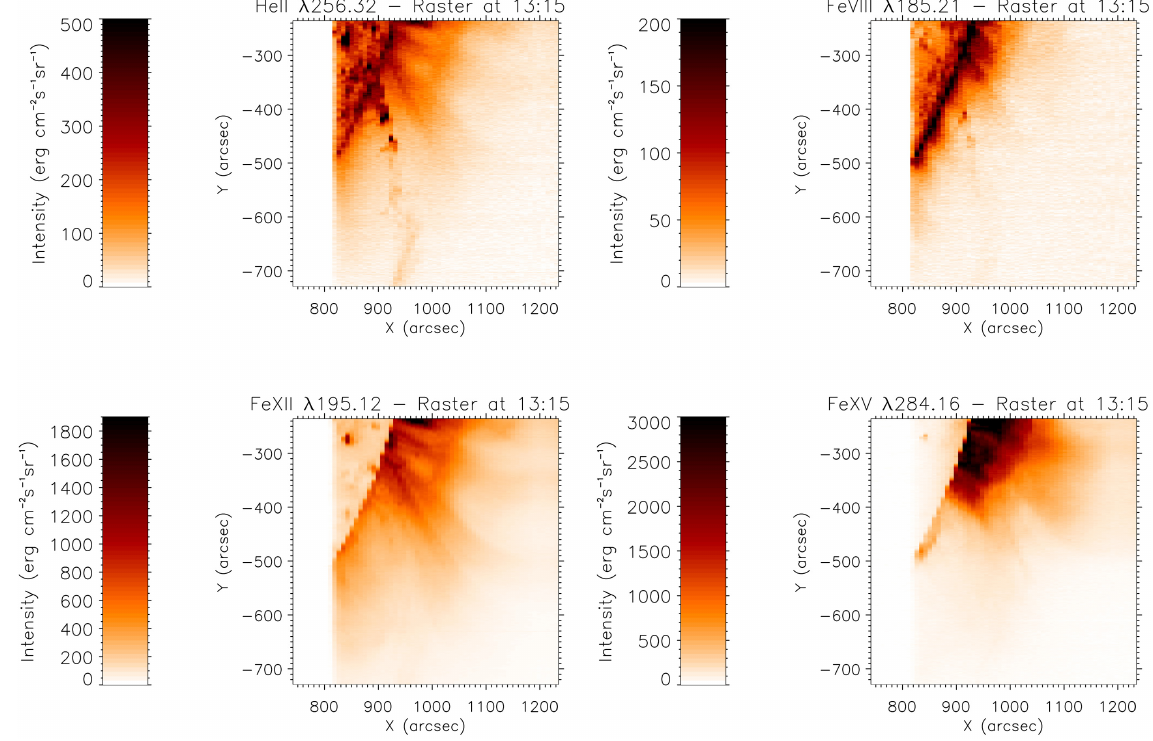
Fig. 5. The erupting filament material and the surrounding corona as seen by EIS in the He II λ 256.32 (top left), Fe VIII λ 185.21 (top right), Fe XII λ 195.12 (bottom left) and Fe XV λ 284.16 (bottom right) spectral line intensities during the 13:15–14:18UT raster (see Fig. 4). The left part of the raster contains missing